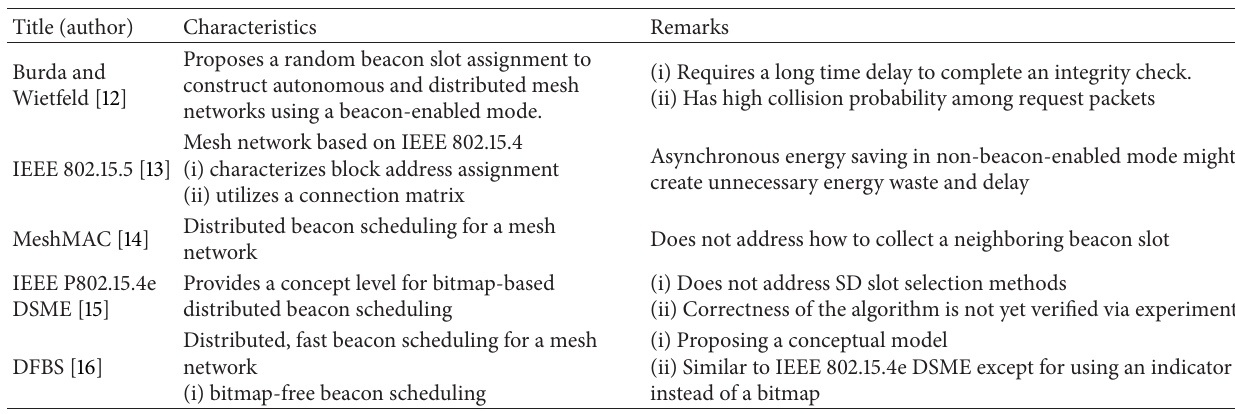
Table 2: Mesh-based beacon